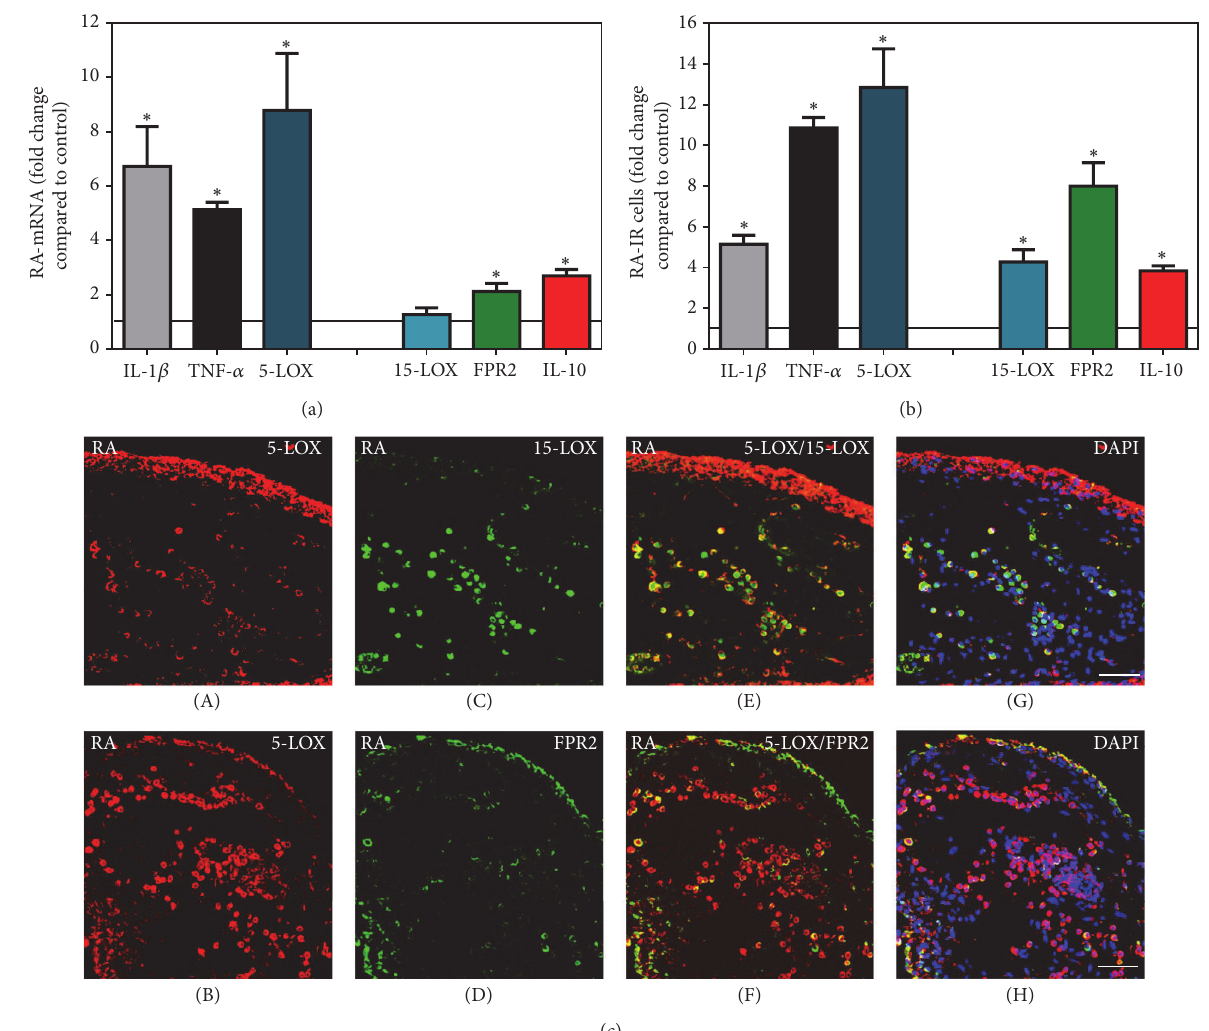
Figure 7: Detection of mRNA (a) and the number of positive cells of pro- (IL-1 𝛽 , TNF- 𝛼 , and 5-LOX) versus anti-inflammatory (15-LOX, FPR2, and IL-10) mediators (b and c) in patients with rheumatoid arthritis (RA). Quantification of mRNA of pro- versus anti-inflammatory mediators shows that proinflammatory mediators expressions were more prominent than anti-inflammatory mediators in RA synovium. ∗ Relative to control ( 𝑃 < 0.05 , one-way ANOVA followed by Tukey’s test). (b) Quantitative analysis of immunofluorescence microscopy pro- versus anti-inflammatory mediators shows that the number of cells expressing proinflammatory mediator expression was more prominent than those containing anti-inflammatory mediators in OA synovium; the asterisks denote significant differences ( 𝑃 < 0.05 , one-way ANOVA followed by Dunn’s test). Data are shown as means ± SEM. (c) Confocal microscopy of pro- ( red fluorescence ; (A) and (B)) and anti- inflammatory mediators ( green fluorescence ; (C) and (D)) double immunofluorescence in RA synovium. Note that proinflammatory mediator expression was more prominent than anti-inflammatory mediators in RA synovium. Bar = 40 𝜇